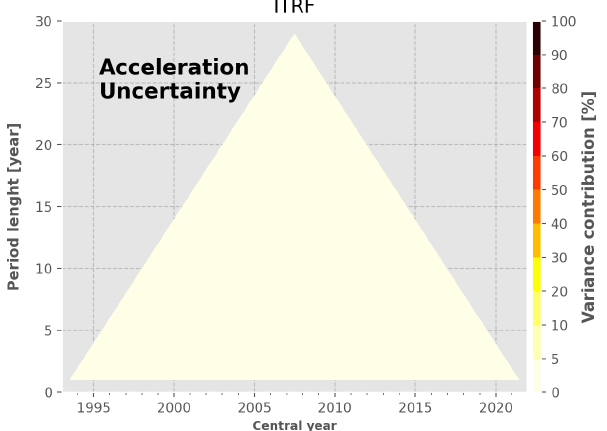
Figure B7. Variance contribution to the GMSL acceleration vari- ance of the ITRF drift uncertainty.